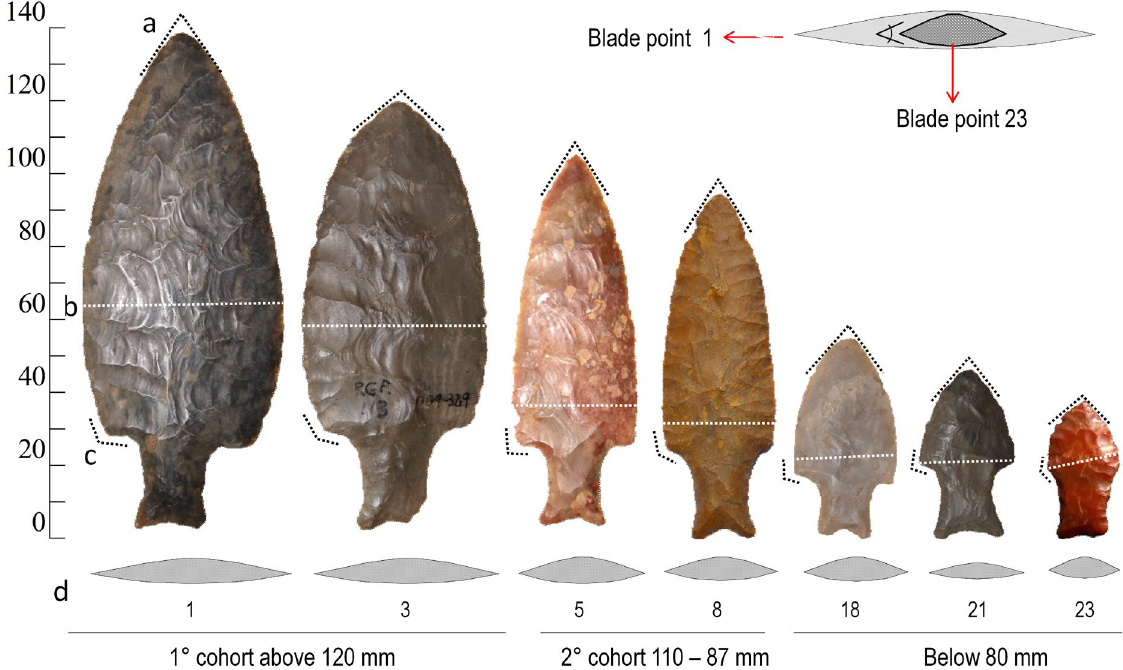
Figure 21. Some morphological features of the points discussed in the text. a: front angles. b: Symmetry of the leading edges; c: shoulders; d: cross-section area and perimeter; e: superimposed images of the sections of pieces 1 and 23. Note the taper tendency of the cross-section of the blades as the pieces became smaller (except piece 21). The dotted lines of the front angles are placed for the purpose of illustration.